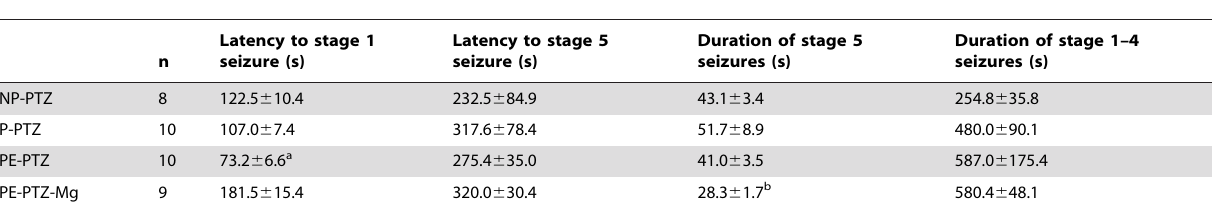
Table 2. The average time-course of the seizure after PTZ i.p. injection on GDs 16–18.